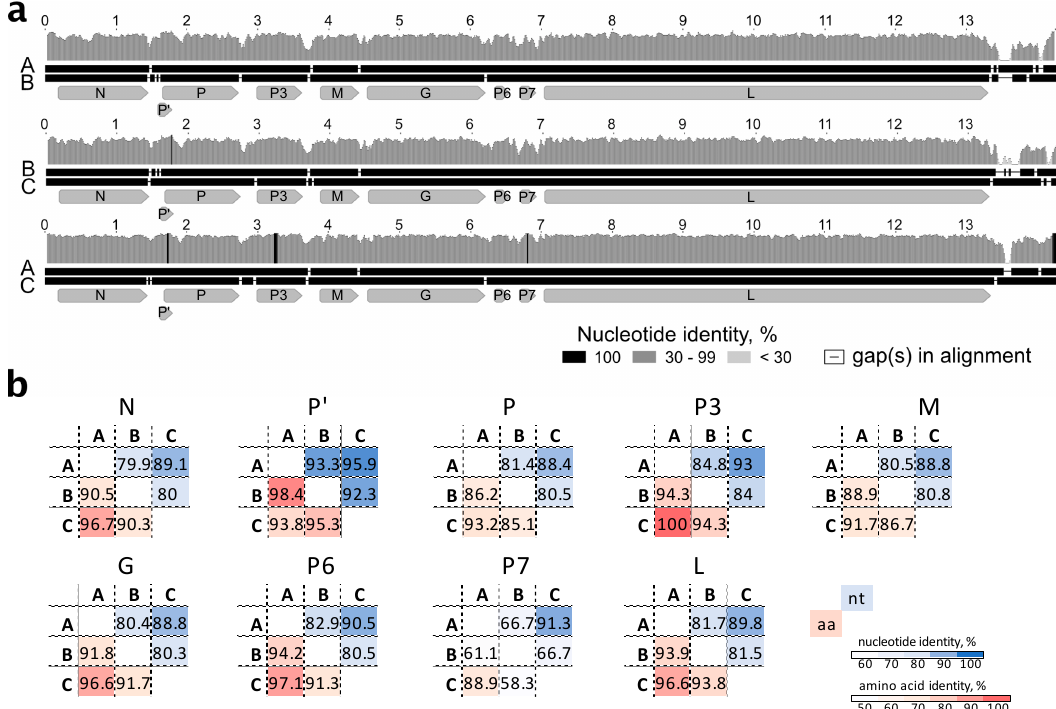
Figure 4. ( a ) Representation of pairwise nt alignments between different genomic genotypes of StrV-1- Č RM1. The vc strands were aligned. Gap regions in alignments are shown as lines. A shade legend of nt identities is shown in the lower right corner. Nucleotide positions are shown above each alignment; ( b ) Sequence nt and aa identities between individual genes and putative proteins of three StrV-1- Č RM1 genotypes.